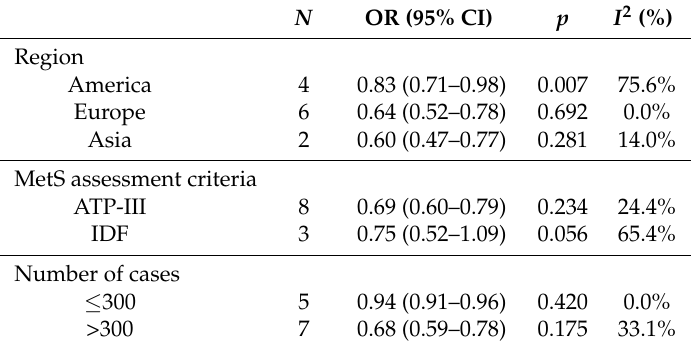
Table 3. Results of subgroup analysis stratified by region, MetS assessment criteria and number of cases.